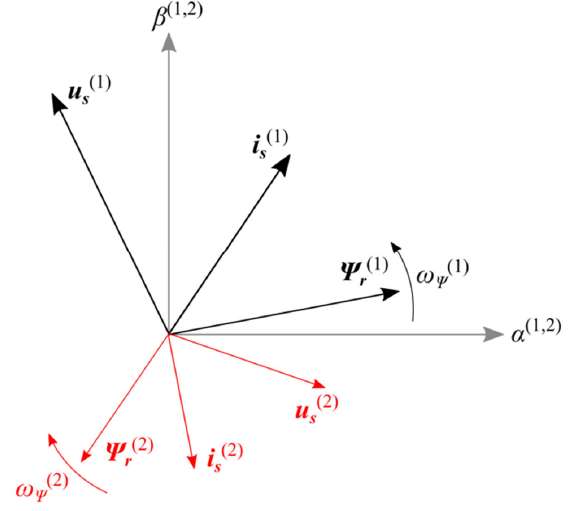
Figure 1. Vectors of voltage, stator current and rotor flux in the double coordinate system α (1,2) - β (1,2) .